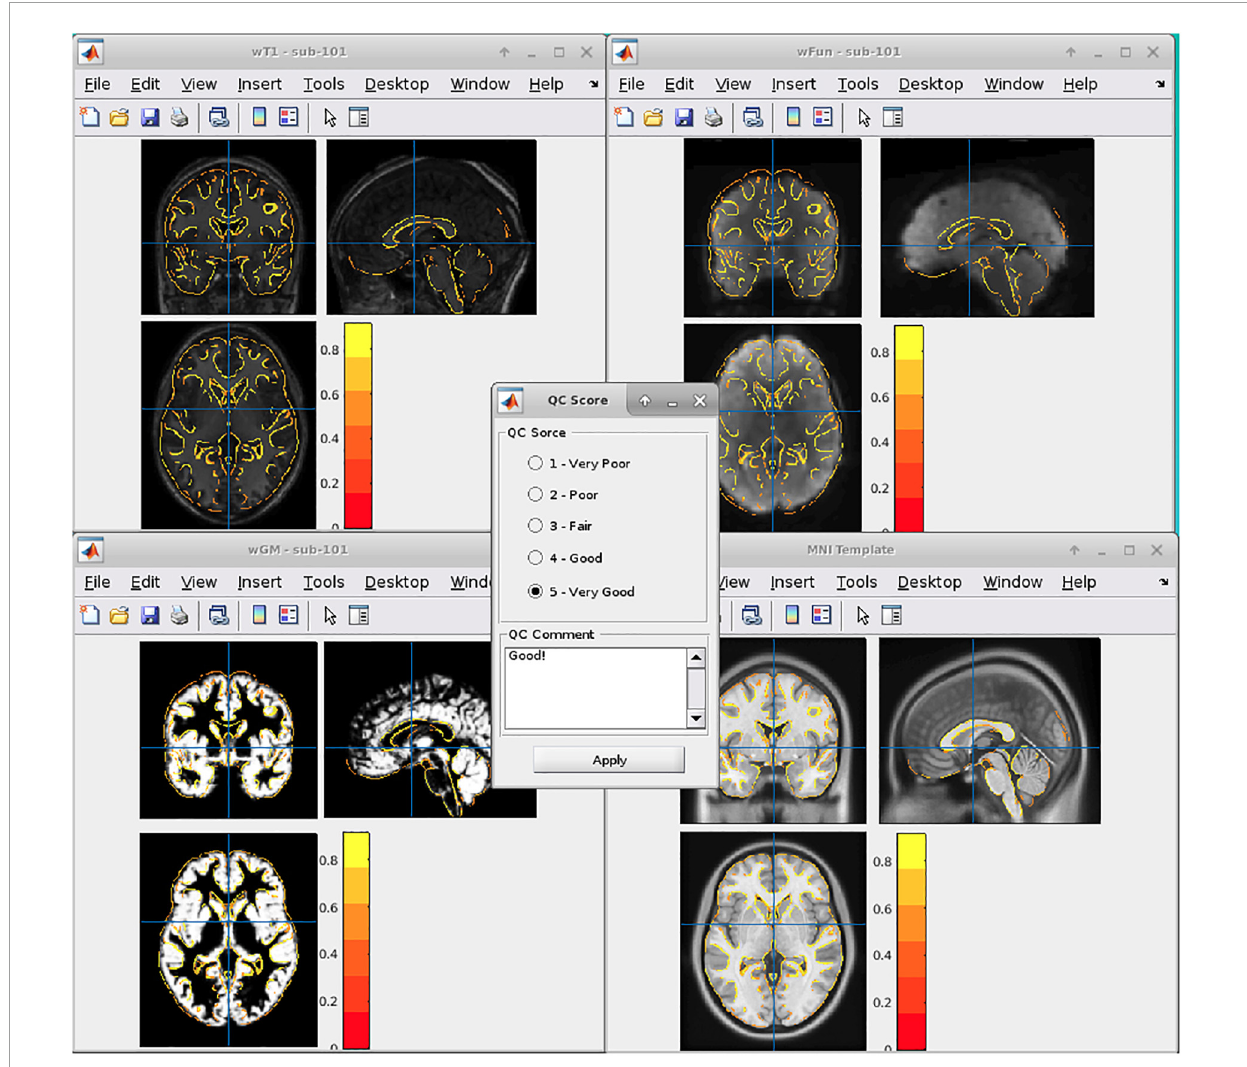
FIGURE1 Graphic user interfaces of the spatial normalization quality control (QC) tools in